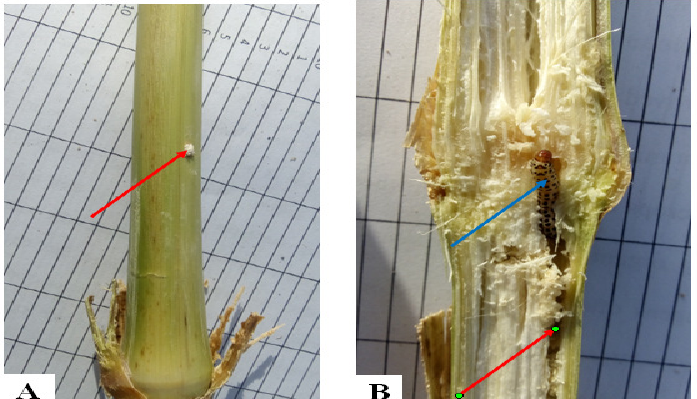
Figure 1. Pearl millet stem infested and damage by stem borer ( Coniesta ignefusalis ) A = Entry hole of stem borer on stem of a susceptible pearl millet B = Blue arrow – Stem borer organism, Red arrow – Damage (Tunnel length) stem Artificial infestation with stem